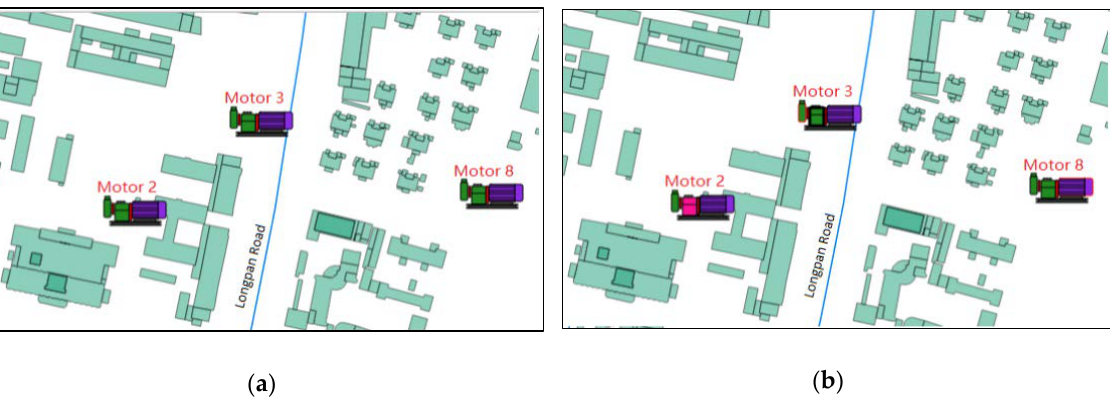
Figure 10. Real-time geo-sensor data visualizations in browser-server architecture, using motors as an example. ( a ) When the temperature of the motors is lower than the threshold, the color of the graphic element is green; ( b ) When the temperature of the motors is higher than the threshold, the color of the graphic element is red.